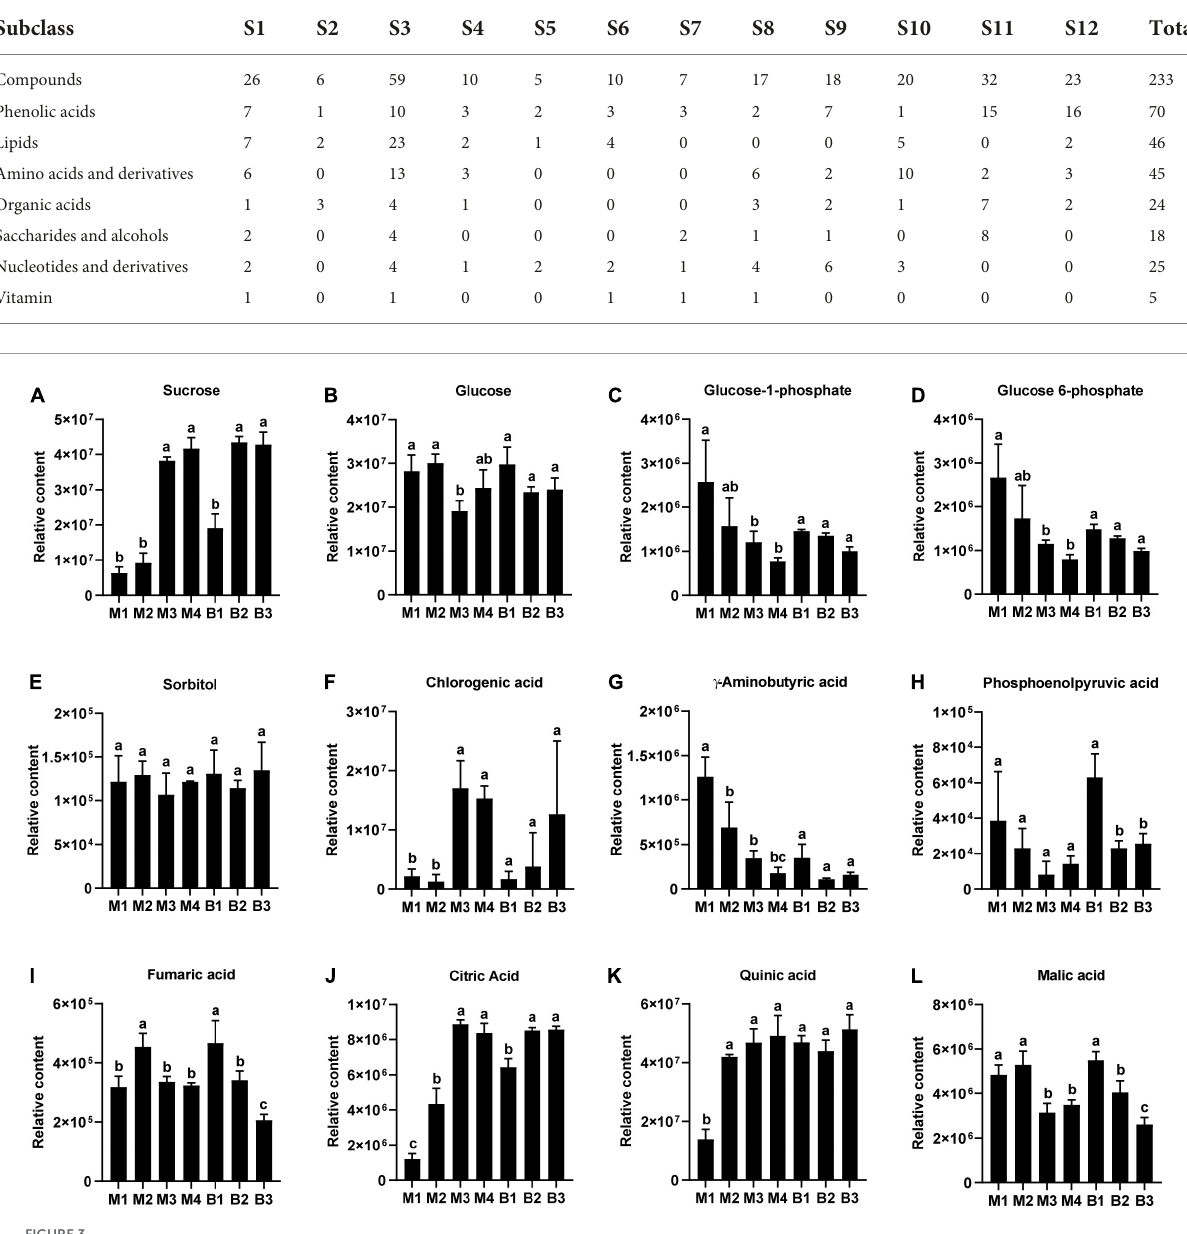
TABLE 2 Distribution of the 233 differentially accumulated metabolites identified among different k-means clusters.